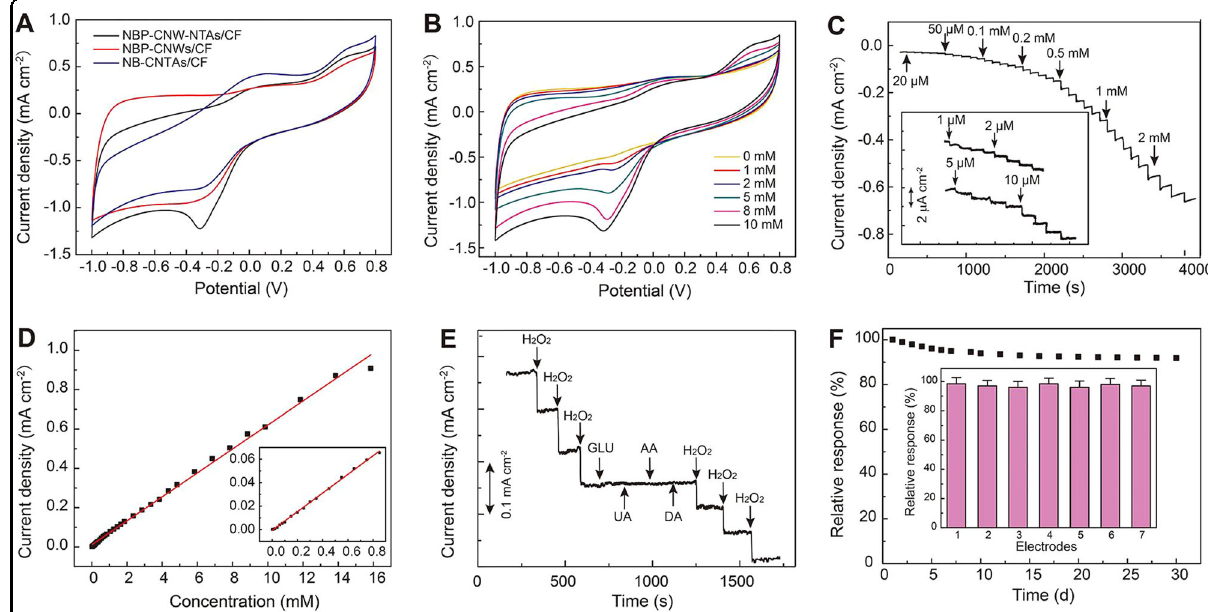
Fig. 3 The electrochemical sensing performances of NBP-CNW-NTAs/CF microelectrode toward H 2 O 2 . A CV curves of NBP-CNW-NTAs/CF, NBP-CNW/CF and NBP-CNTAs/CF microelectrodes in 0.1 M PBS solution containing 8 mM H 2 O 2 . Scan rate: 50 mV s − 1 . B CV curves of the NBP-CNW- NTAs/CF microelectrode in 0.1 M PBS solution (pH 7.4) containing 0, 1, 2, 5, 8, and 10 mM H 2 O 2 . C Amperometric j -t responses of the NBP-CNW-NTAs/ CF microelectrode to the addition of different H 2 O 2 concentrations into 0.1 M PBS (pH 7.4) under stirring. Inset of ( C ) is the amperometric response of the NBP-CNW-NTAs/CF microelectrode to a low concentration of H 2 O 2 . Applied potential: − 0.25 V. D Calibration curves of the linear relationship between the corresponding current densities and H 2 O 2 concentrations. E Amperometric response of the NBP-CNW-NTAs/CF microelectrode to the successive addition of 0.5 mM H 2 O 2 and 5.0 mM GLU, UA, AA and DA in 0.1 M PBS at − 0.25 V. F Relative response of the NBP-CNW-NTAs/CF microelectrode to 0.5 mM H 2 O 2 for 30 days. The inset is the relative response of seven different electrodes to 0.5 mM H 2 O 2